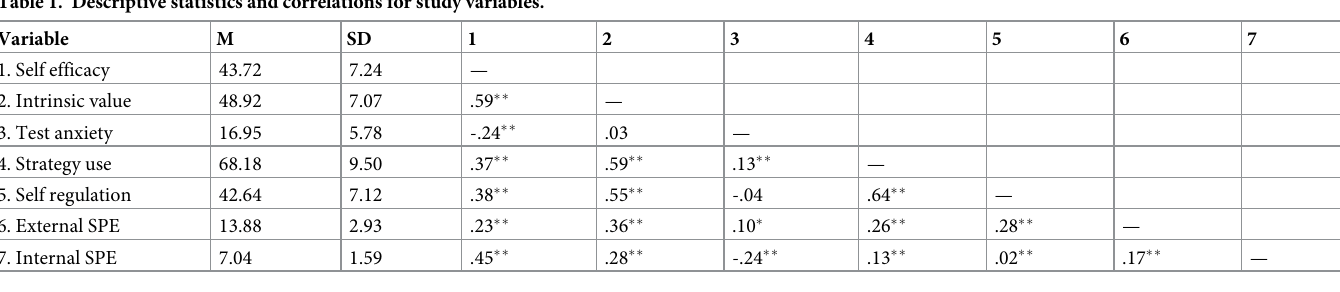
Table 1. Descriptive statistics and correlations for study variables.